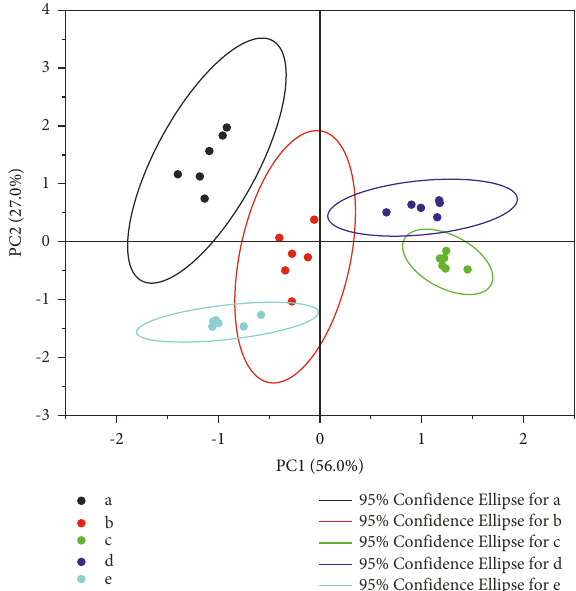
Figure 5: Phenolic compounds contents in smokers’ saliva for five kinds of cigarettes (a, b, c, d, and e) determined by principal component